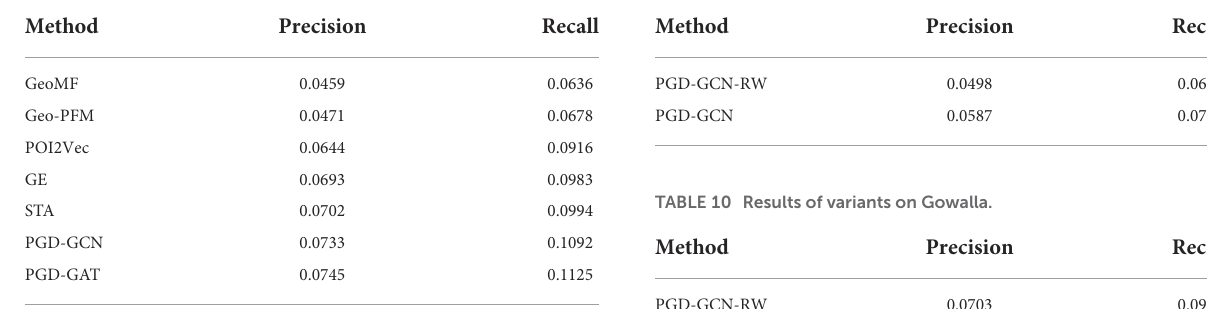
TABLE 4 Results of all methods on Gowalla.